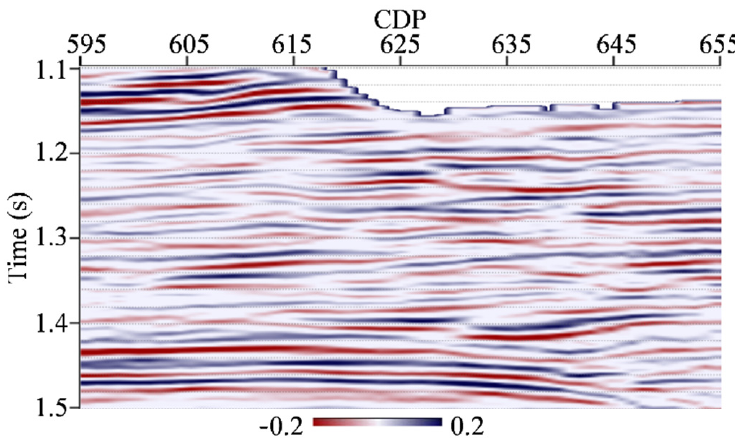
Figure 9. The inverted reflectivity series